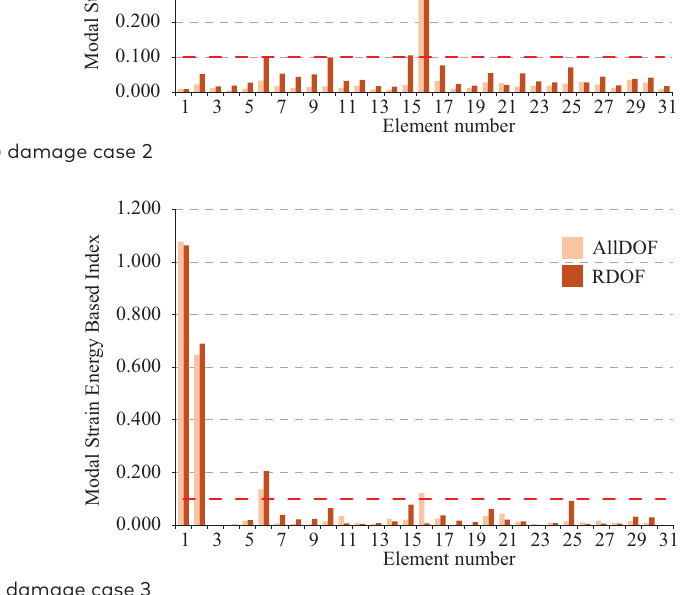
Figure 10. Damage index values in 31-element truss for seven